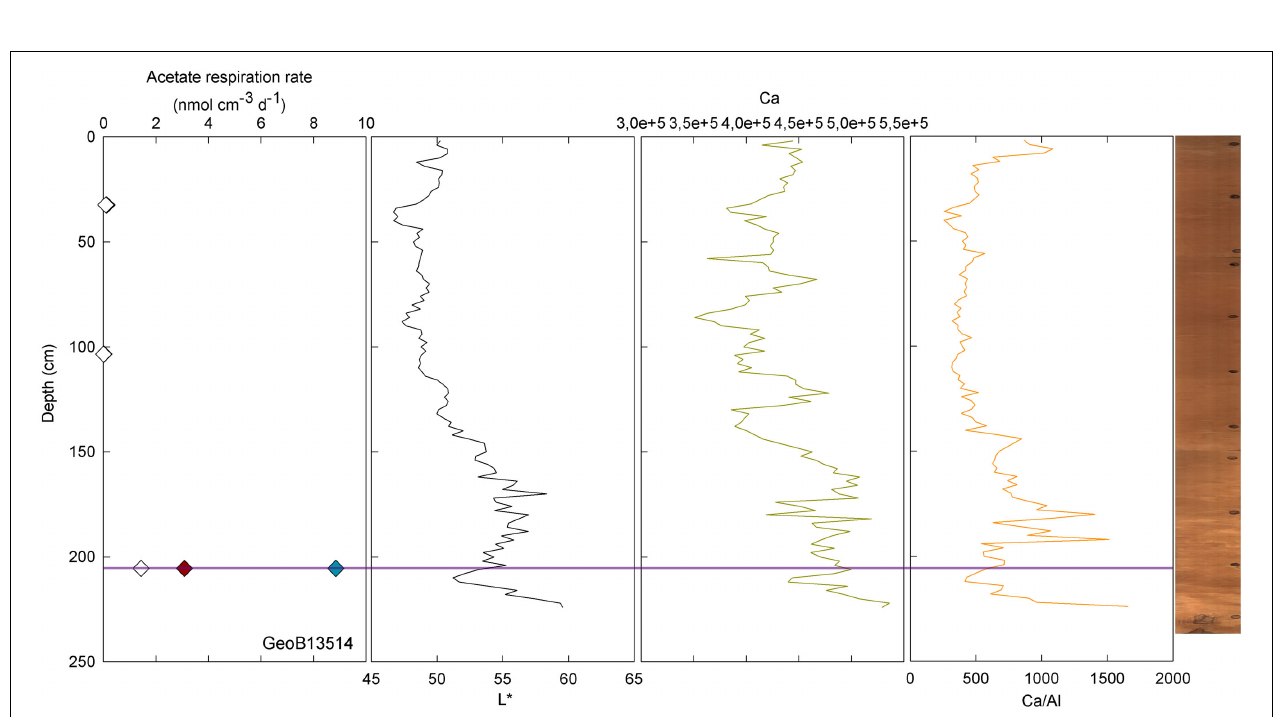
FIGURE 7 | GeoB 13514 linked activities (at 32.5, 103.5, and 205.5cm) and lithological features (L ∗ , Ca, and Ca/Al). Purple line denotes depths of greater potential acetate turnover.